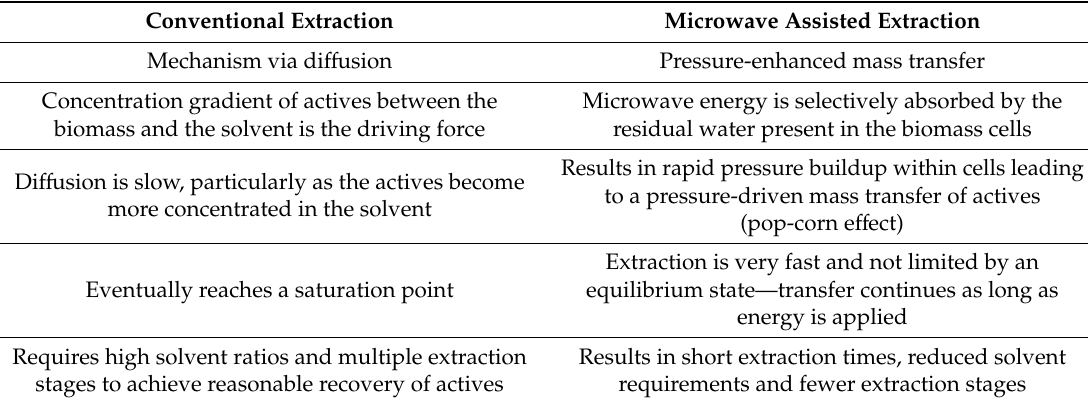
Figure 3. Conventional vs. Microwaves extraction. Biomass—(non-polar) solvent extraction: Solvent—green dots; Biomass—red-purple sphere, colours indicating the variation in temperature from cold (purple) to hot (red). Table 1. Solvent-biomass extraction: Conventional vs. Microwaves.